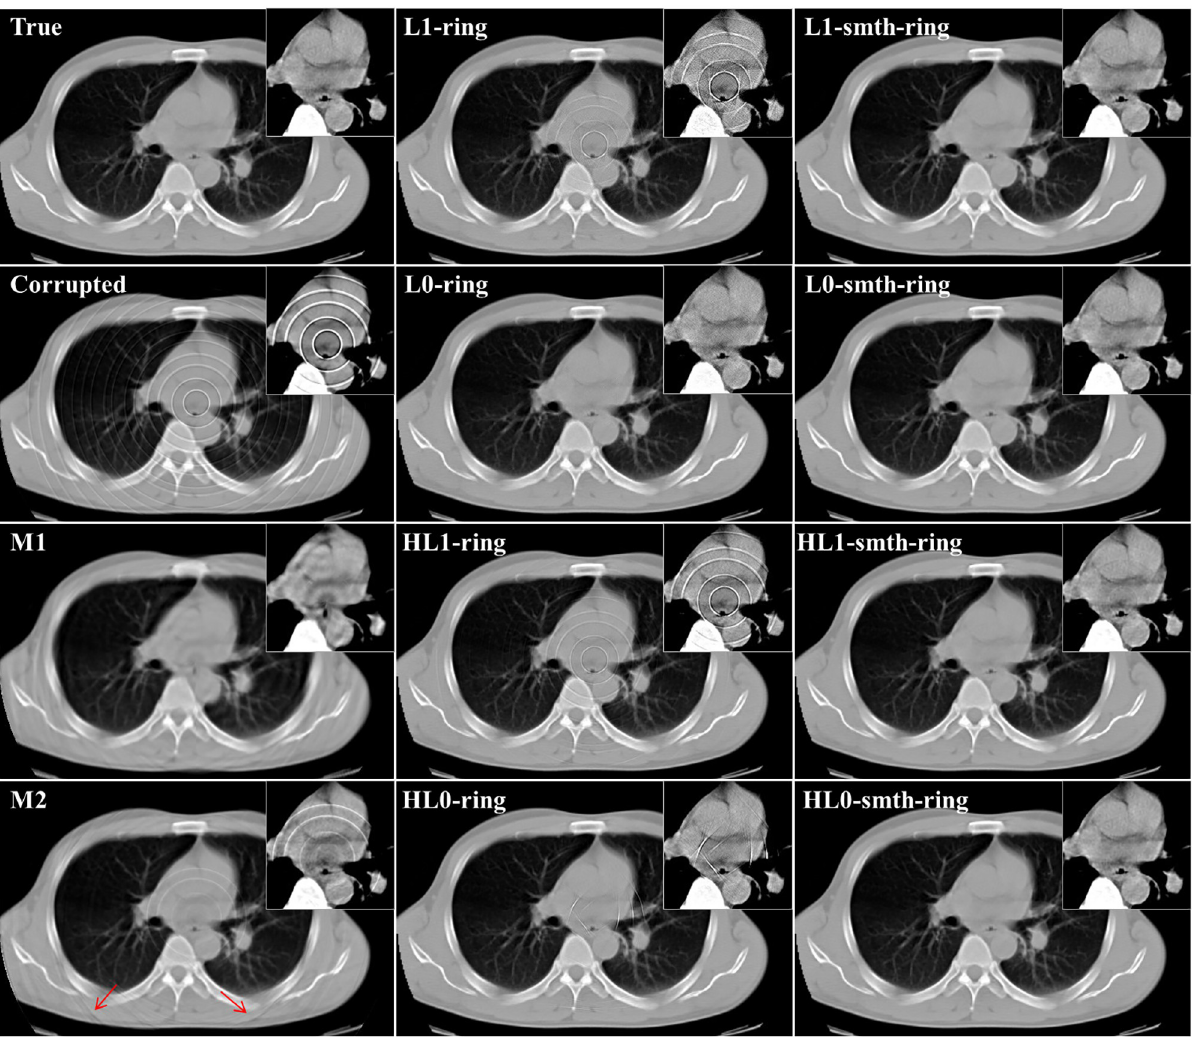
Fig 5. Reconstructed images in the third study case (noise-free, adjacent bad detector bins, and angular-dependent error case).